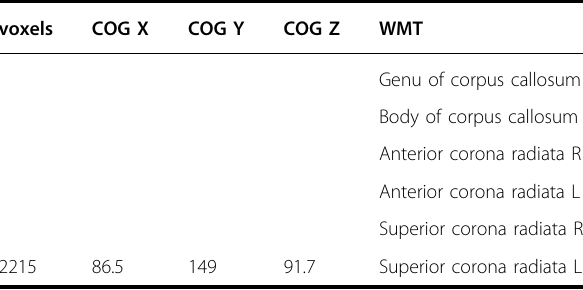
Table 3 Anatomical locations of signi fi cant voxelwise analysis.